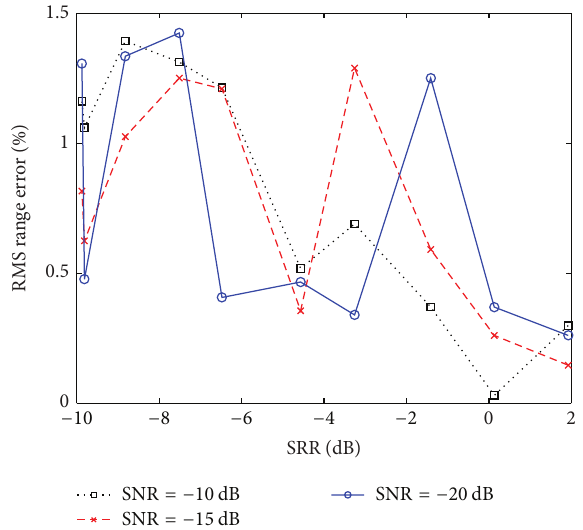
Figure 9: The RMS range errors of single target over different SNR and SRR values.